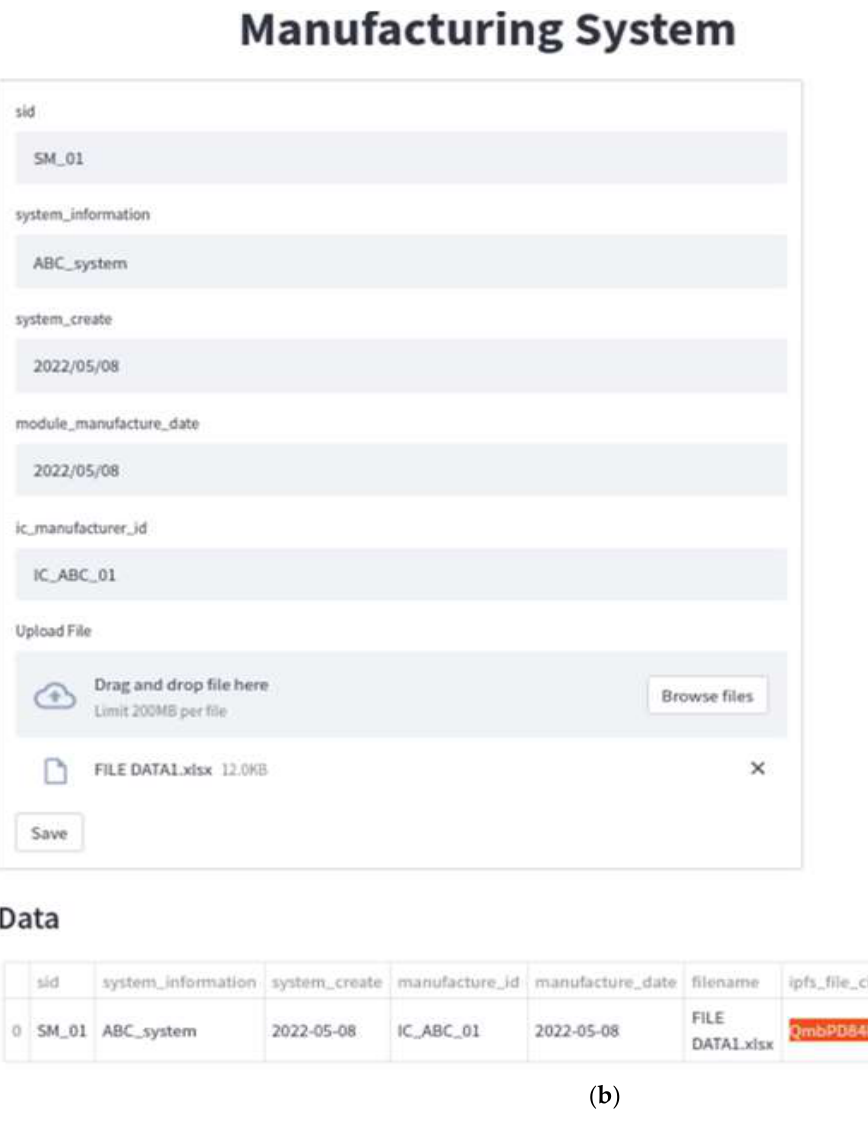
Figure 9. ( a ) DApp of SM (this SM could be called a new MS production); ( b ) DApp of SM with the input data.